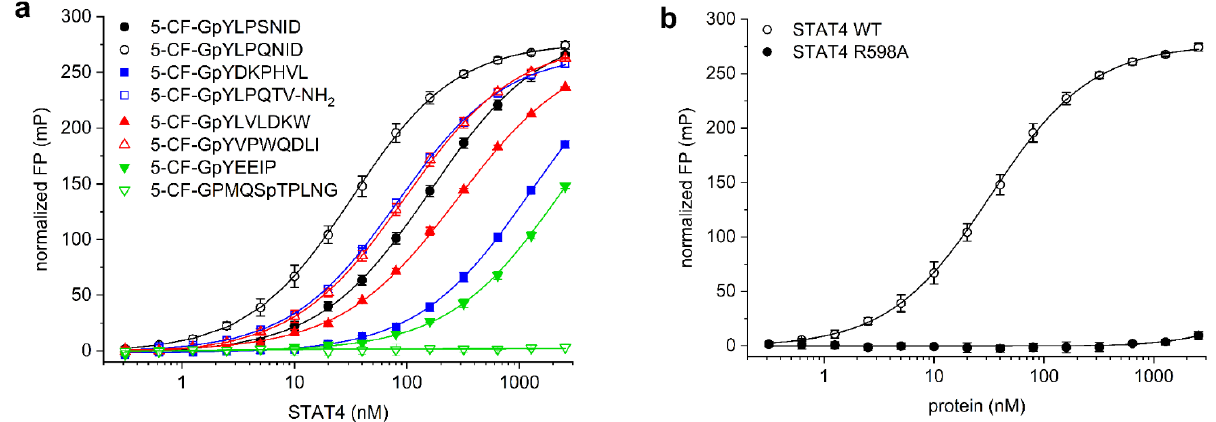
Figure 1. ( a ) Binding of fluorescent-labelled phosphopeptides probes to STAT4. ( b ) Binding of 5- CF-GpYLPQNID to STAT4 wild-type (WT) and the point mutant STAT4